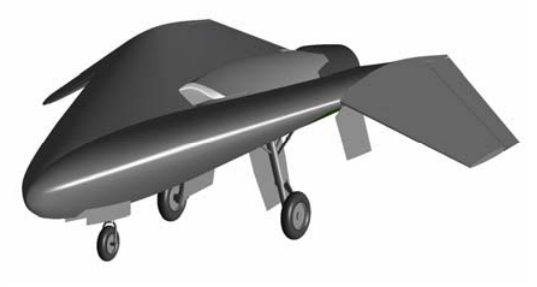
Fig 14. PW-124 aircraft – engine inlet is visible the body top